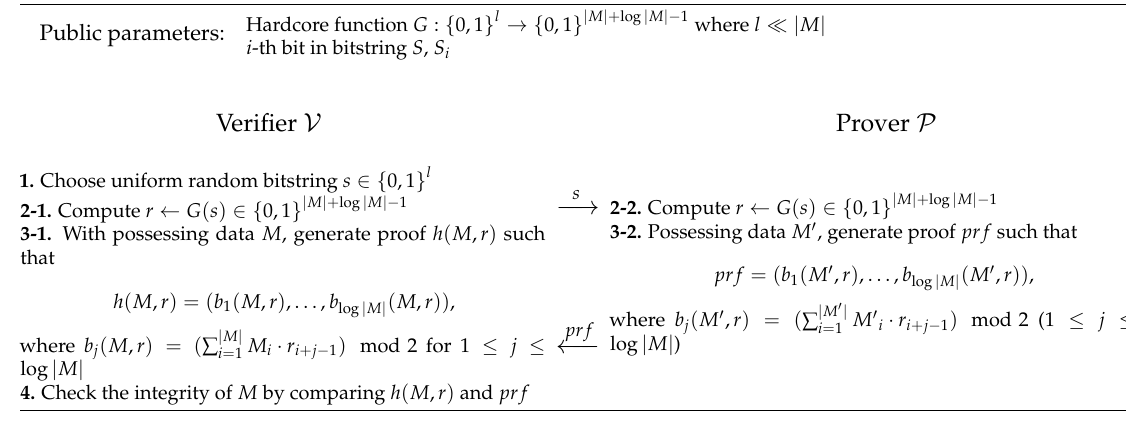
Algorithm 1 Randomized online authentication exploiting a hardcore